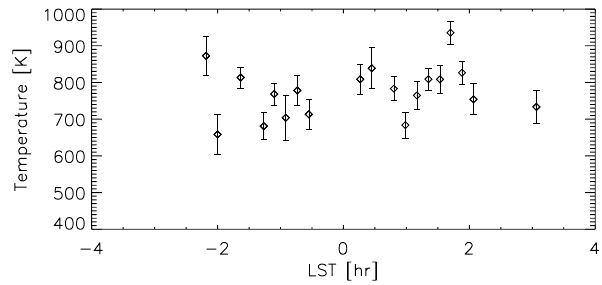
Fig. 5. Nighttime OI 630-nm thermospheric temperatures obtained by SOFDI from the night of 11 August to 12 August 2010. Data from the different pointing-head look directions was not separated and demonstrates the spatial variability of the temperature measure-